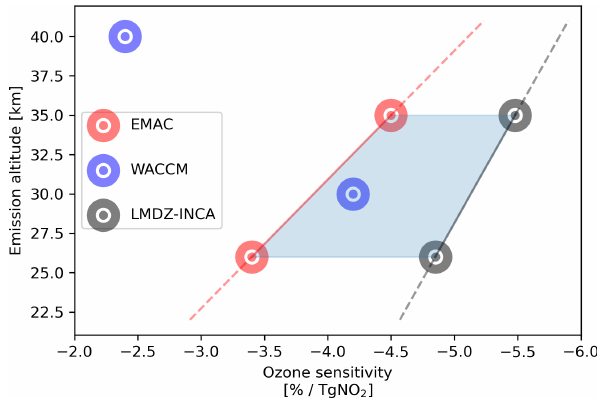
Figure 10. Ozone sensitivity, dependent on altitude of emission, from three different models WACCM, EMAC and LMDZ-INCA. Results from this work were calculated using values from Tables 2 and 4. Results for WACCM were published by Kinnison et al. (2020, Table 2). The shaded area highlights the good agreement of LMDZ-INCA and EMAC results with WACCM results for the region from approximately 26–35km